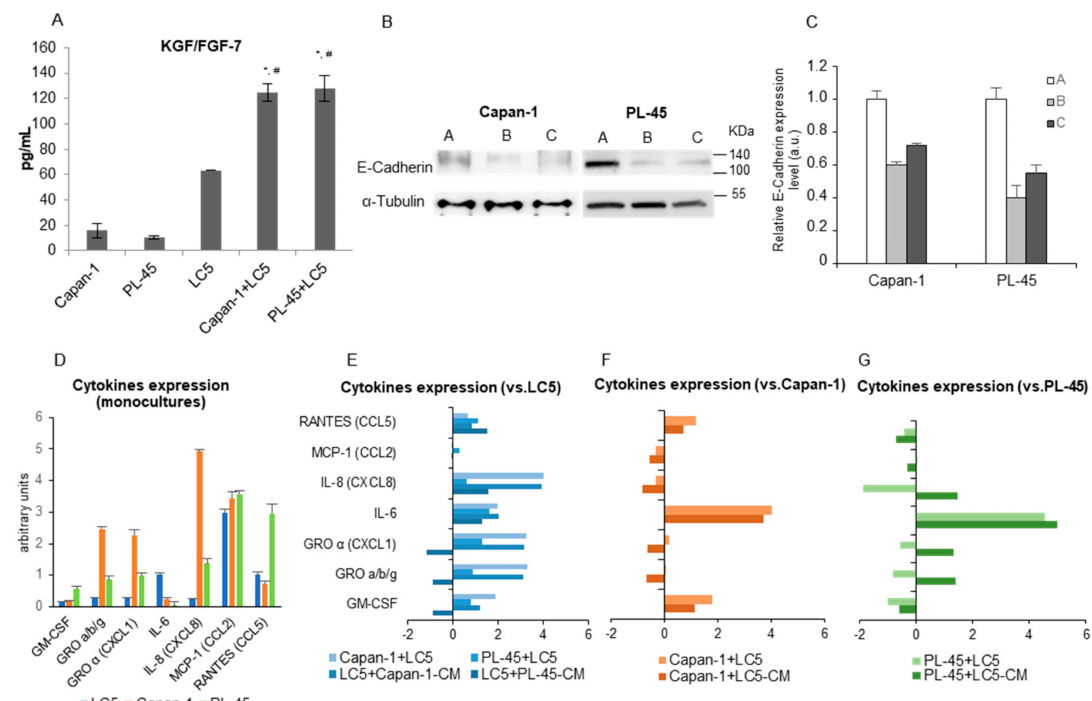
Figure 3. Changes in protein expression and cytokine secretion in coculture models. KGF/FGF-7 concentration from supernatants of monoculture and fibroblasts-pancreatic tumor cells cocultures. FGF-7 concentration in cocultures was significantly higher than that in monocultures (*—LC5, #—corresponding tumor cell line; p < 0.0001). Data represent mean ± SD of three independent assays ( A ). Expression of epithelial mesenchymal transition (EMT) marker E-cadherin in pancreatic tumor cells by immunoblotting is shown. Loading control— α -Tubulin ( B ). Representative quantification of E-cadherin expression from Western blot is shown. A: cells grown alone at monoculture. B: cells grown at cocultures with fibroblasts (protein extracts obtained after sorting), and C: cells grown with CM from fibroblast ( C ). Quantification of secretome dot blots from LC5, Capan-1 and PL-45 cells growing as monocultures according to AAH-CYT-1 human cytokine antibody array is shown—represents the molecules most significantly expressed ( D ). Relative differences are shown by cytokine expression levels compared to LC5 monoculture ( E ), compared to Capan-1 monoculture ( F ), and compared to PL-45 monoculture ( G ). X -axis values shown are log2 of the normalized